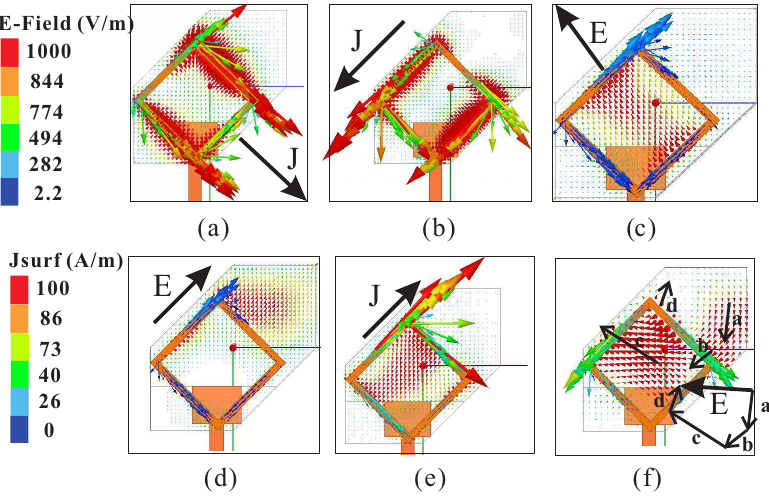
Figure 5. Simulated E-field (cid:126) E and surface current (cid:126) J distributions with respect to phase angle in the proposed design: ( a ) 1.865 GHz ∠ 0°; ( b ) 1.865 GHz ∠ 90°; ( c ) 2.67 GHz ∠ 0°; ( d ) 2.67 GHz ∠ 90°; ( e ) 3.645 GHz ∠ 0°; ( f ) 3.645 GHz ∠